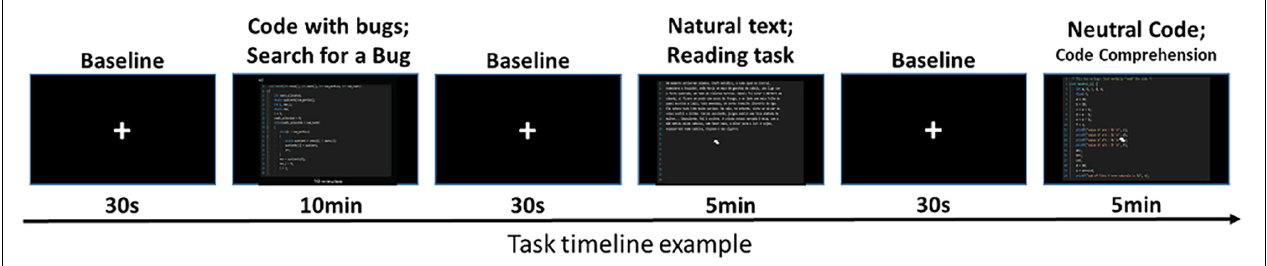
FIGURE 1 | Task timeline. Code with and without bugs and natural text blocks were presented randomly interleaved with a fixation cross for rest. Participants were instructed to search for bugs (error-monitoring/discovery), read the story (Text; control task), and perform a code comprehension task. These stimuli had more than one page, and the participants could navigate the code/text pages with a